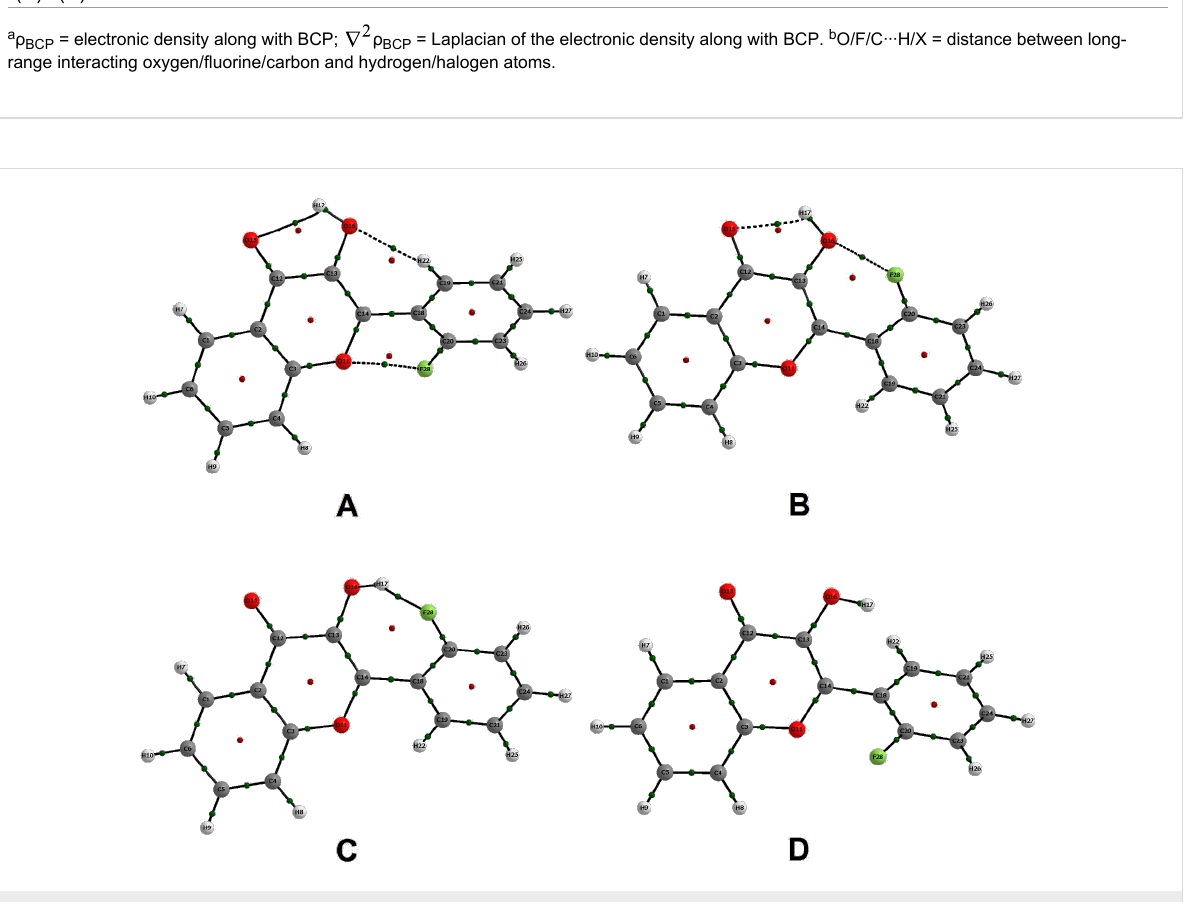
Figure 2: Stable conformers of